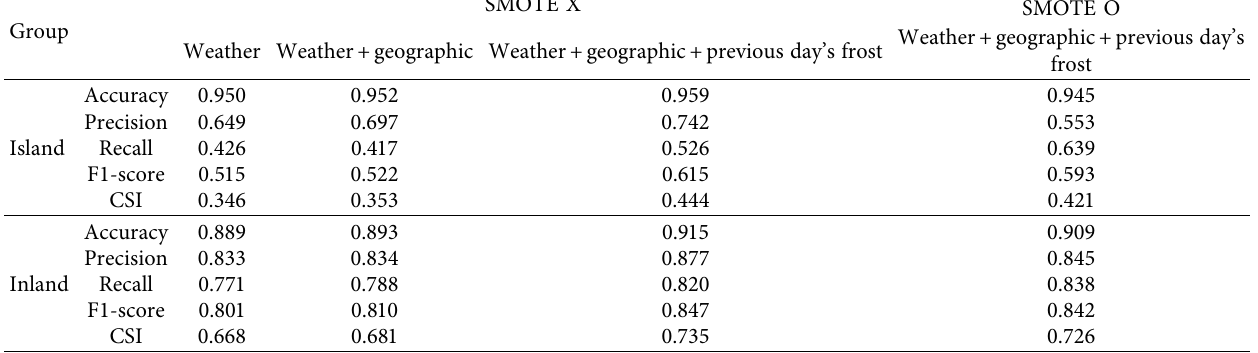
Table 10: Summary of XGBoost results by